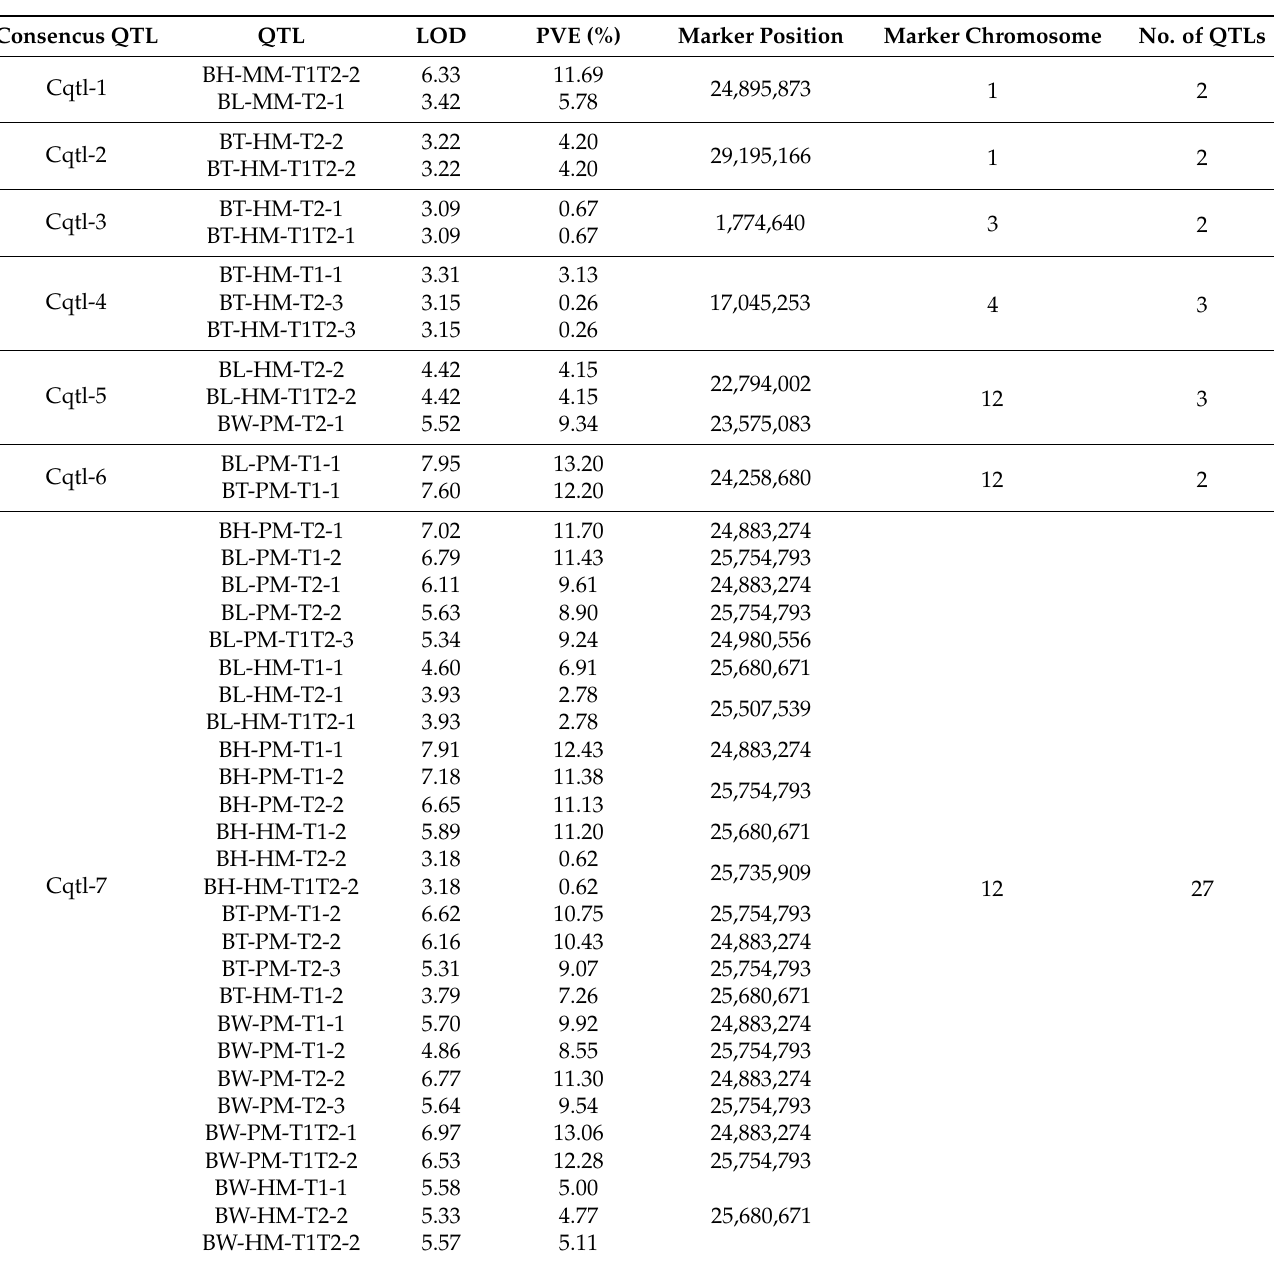
Table 3. Consensus QTLs identified for growth